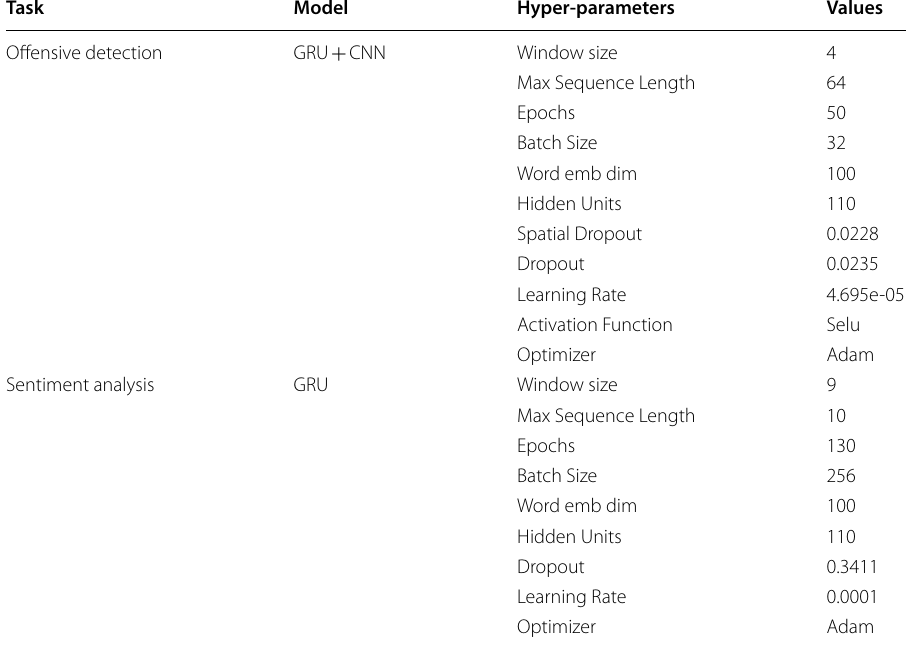
Table 5 Overview of the optimal hyper-parameters for the best performing models for both the tasks